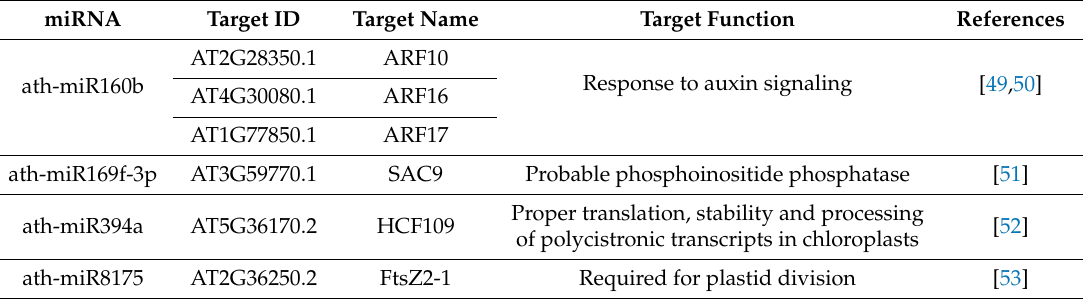
Table 1. Most significant hits from the prediction of mRNA targets for confirmed miRNAs, obtained using the psRNATarget software. More potential targets and search parameters are presented in Supplementary Table S3.